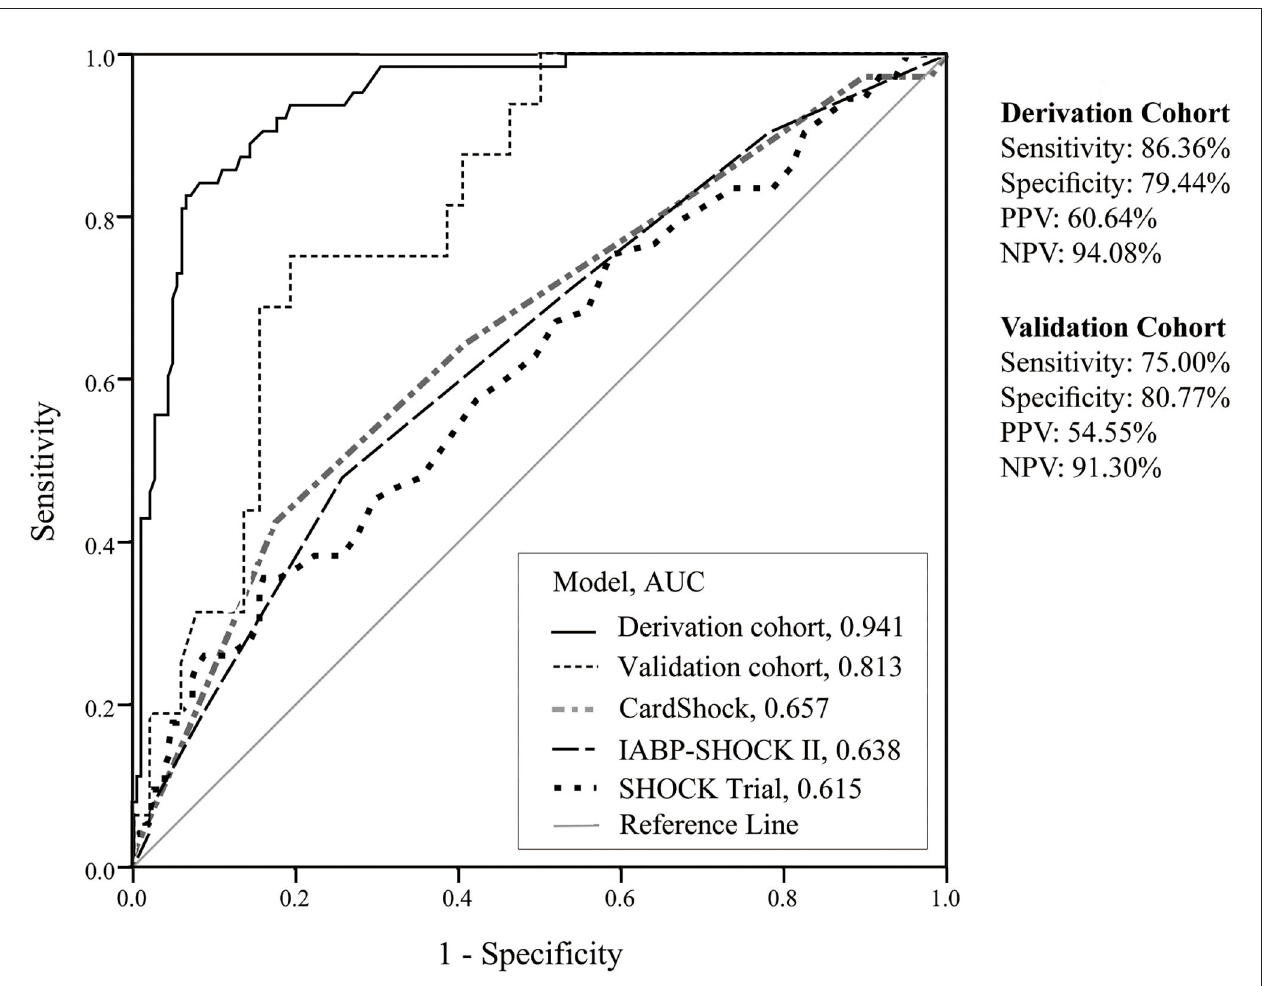
FIGURE 3 | Discrimination performances of derivation cohort, validation cohort, and other scores. AUC, area under the curve; NPV, negative predictive value; PPV, positive predictive